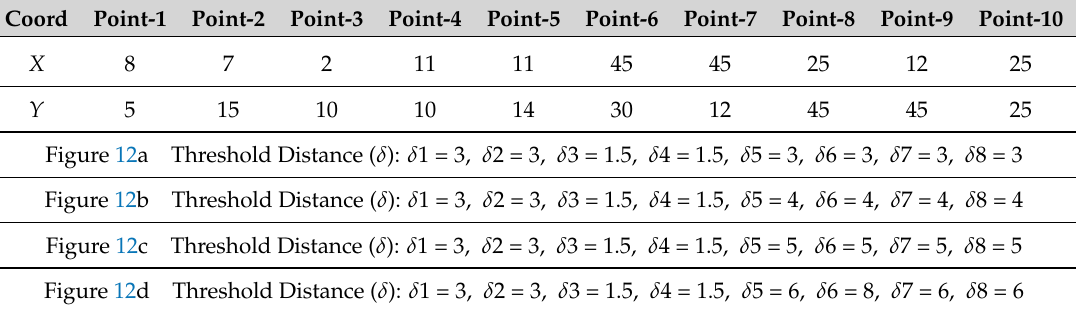
Table 5. Coordinates of different points in the comparative work of Figure 12 for different cases.